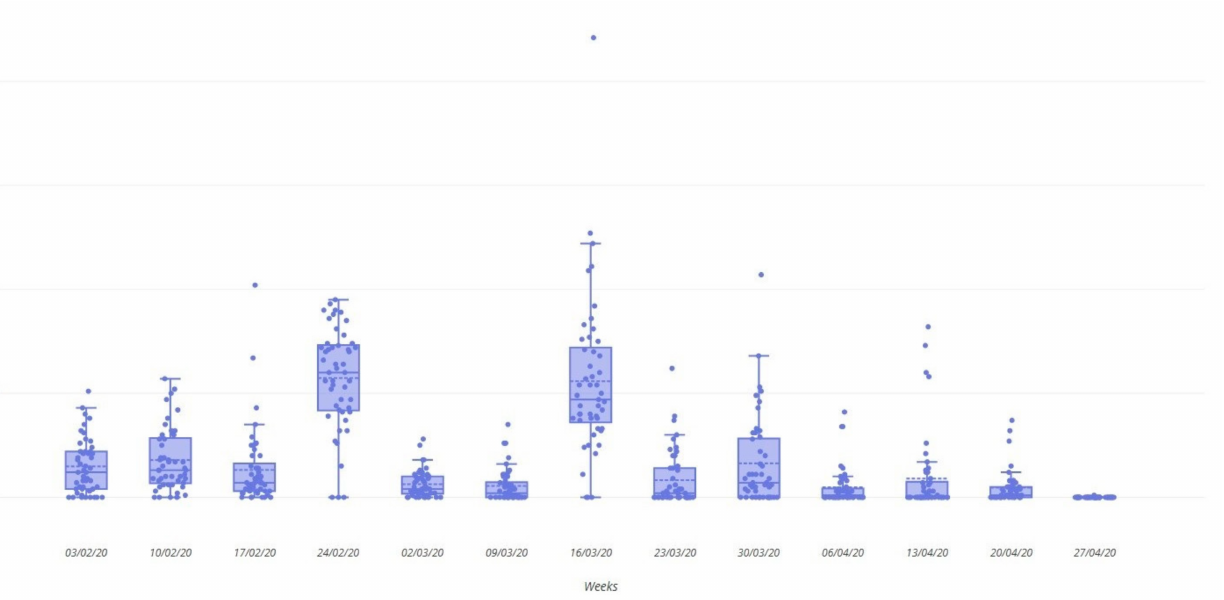
Figure 3. Boxplot of the weekly monitoring of students and detection of outliers in Moodle carried out with UBUMonitor [35].